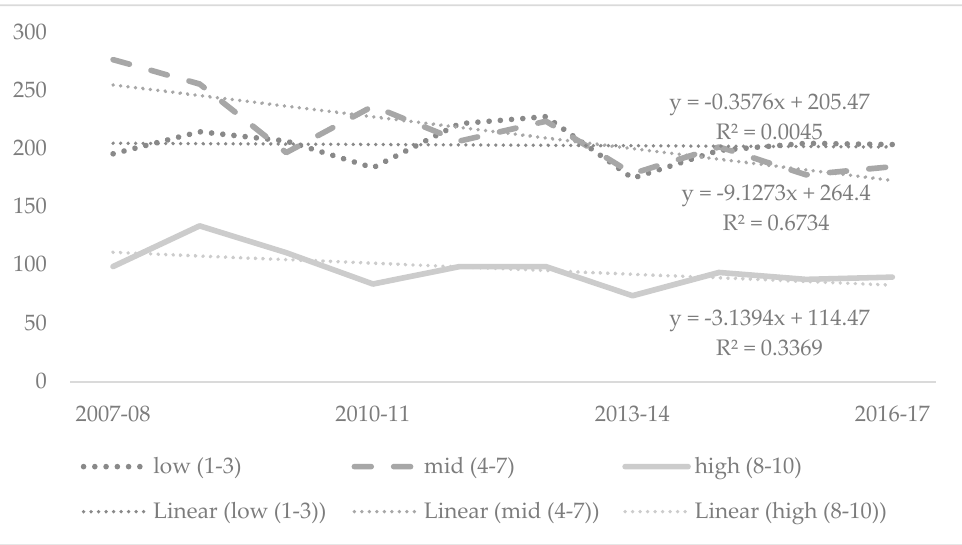
Table 6. Injury-related fatalities by sex and index of relative socio-economic advantage and disadvantage decile (IRSAD), Australia, 2007-08 to 2016-17.